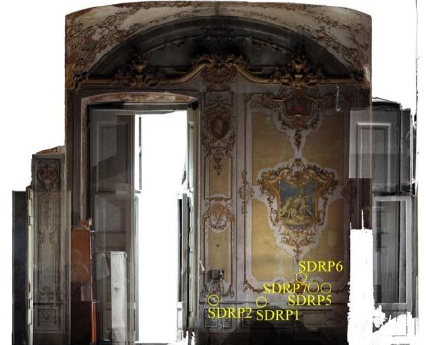
Figure 6. Laser scanner survey of the Gabinetto of gilded stucco. Wall 2 with sampling points.